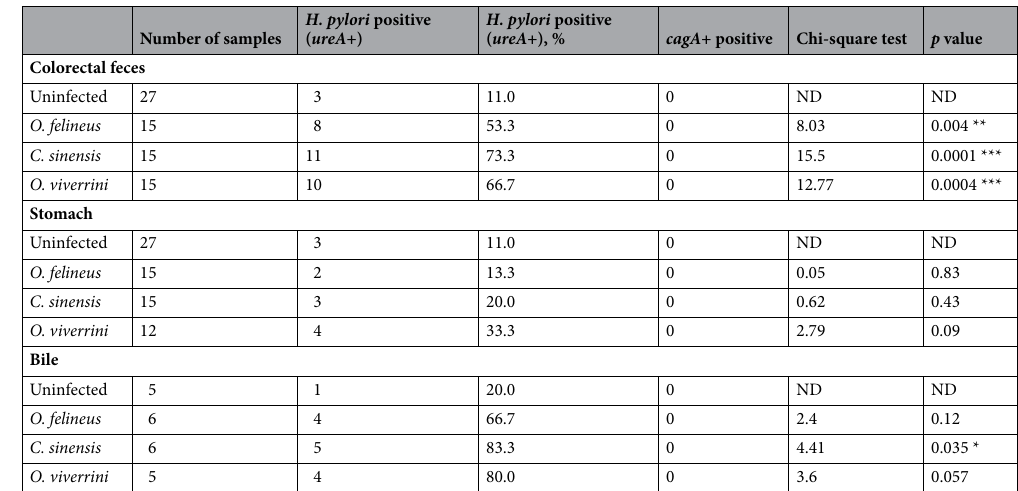
Table 1. Prevalence of H . pylori among gastric, stool, and bile samples, as detected by PCR. To compare two groups, nonparametric data were analyzed with the χ 2 test. Data with p values < 0.05 were considered significant. *A difference between groups (liver fluke–infected vs. uninfected), * p < 0.05; ** p < 0.001; *** p < 0.001; ND: not determined.